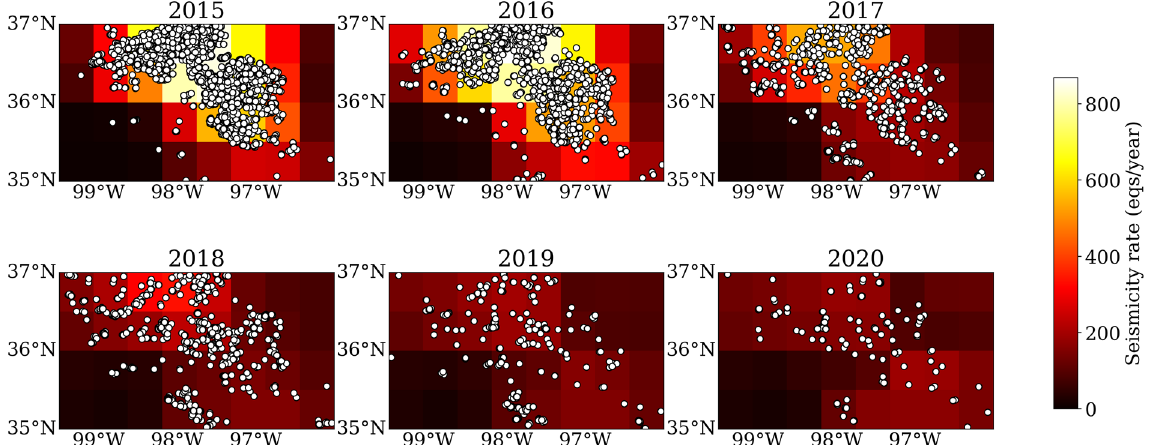
Figure 2. The forecast annual earthquake number for the study area. The white circles denote earthquakes occurred during each year. The annual forecast is the sum of the monthly forecast in each year.